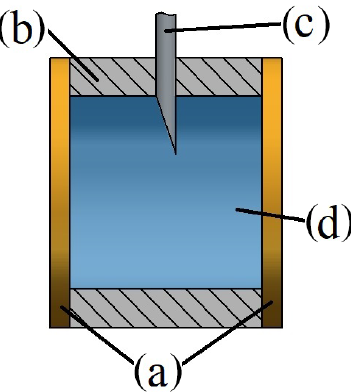
Figure 1. Cross section of the parts surrounding the sample: (a) quartz disks, (b) sample chamber, (c) injection needle (the sec- ond one is behind the first and, therefore, not visible in this view) and (d) sample